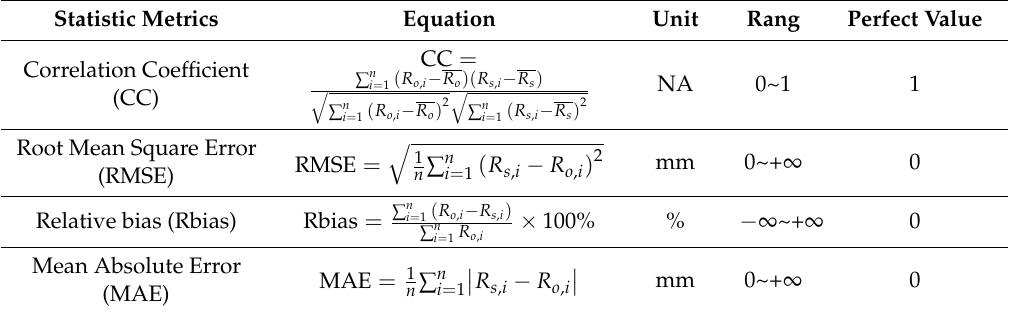
Table 1. List of the continuous statistical indices used to compare the Global Precipitation Measurement (GPM)-era satellite-based precipitation estimations (GSPEs) and the gauged observations.